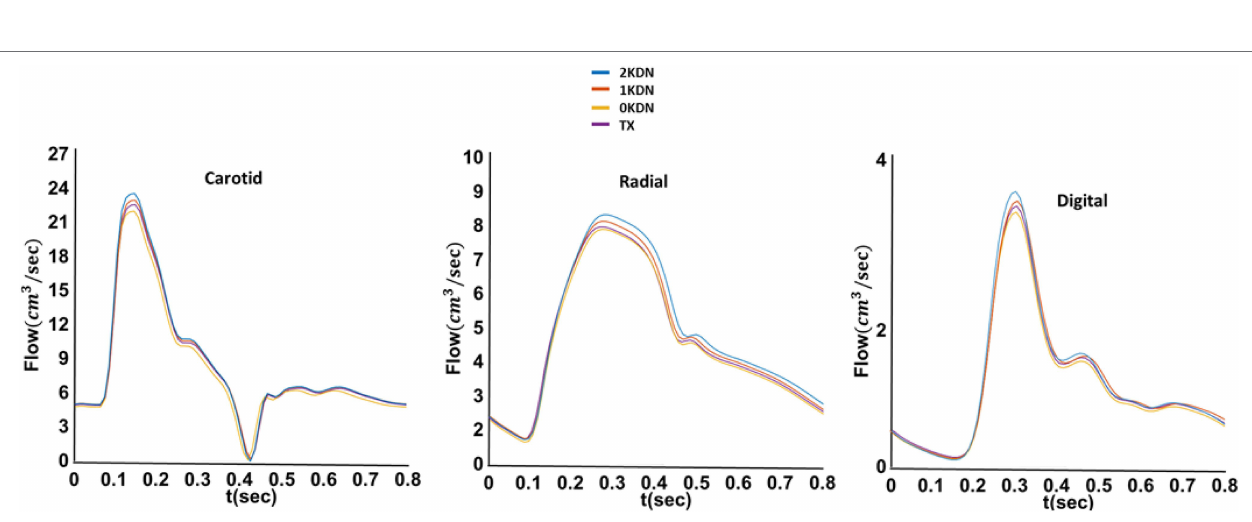
FIGURE 6 | Variations of the carotid, radial, and digital flow waveforms in the four simulated configurations (default distensibility and in silico